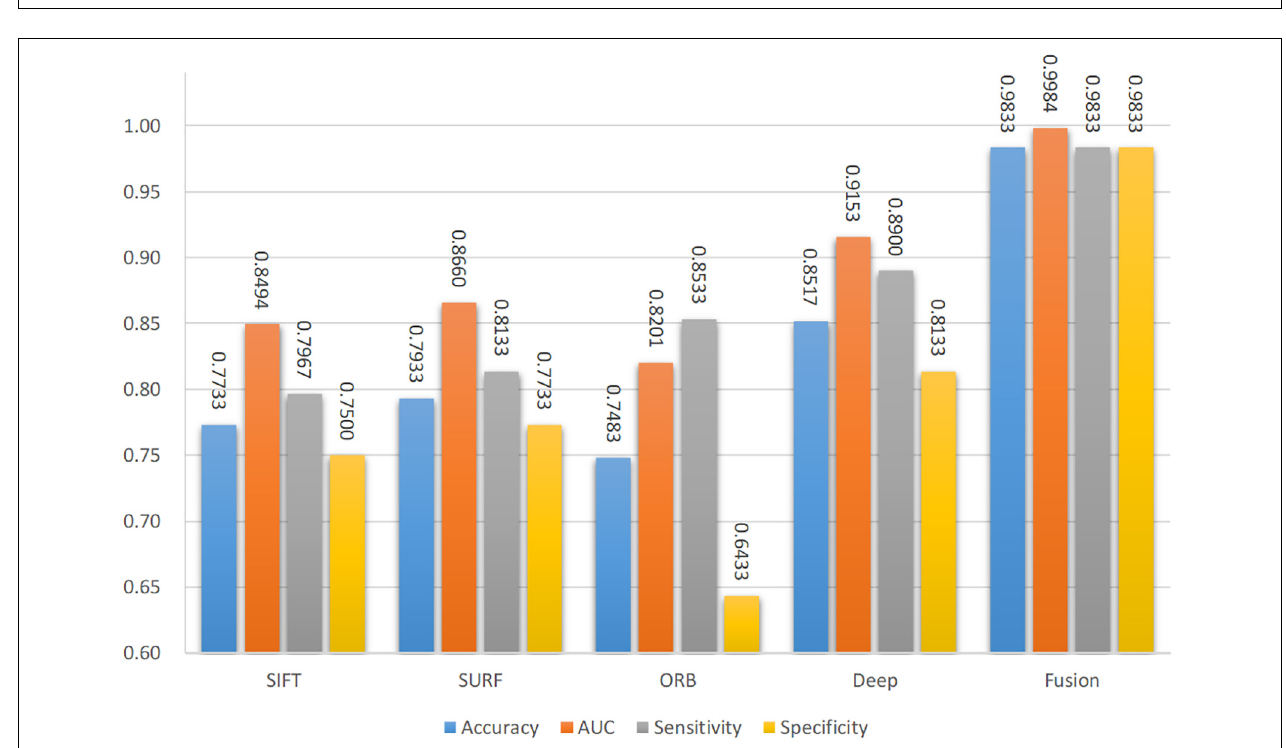
FIGURE 11 | Performance of single features and fusion